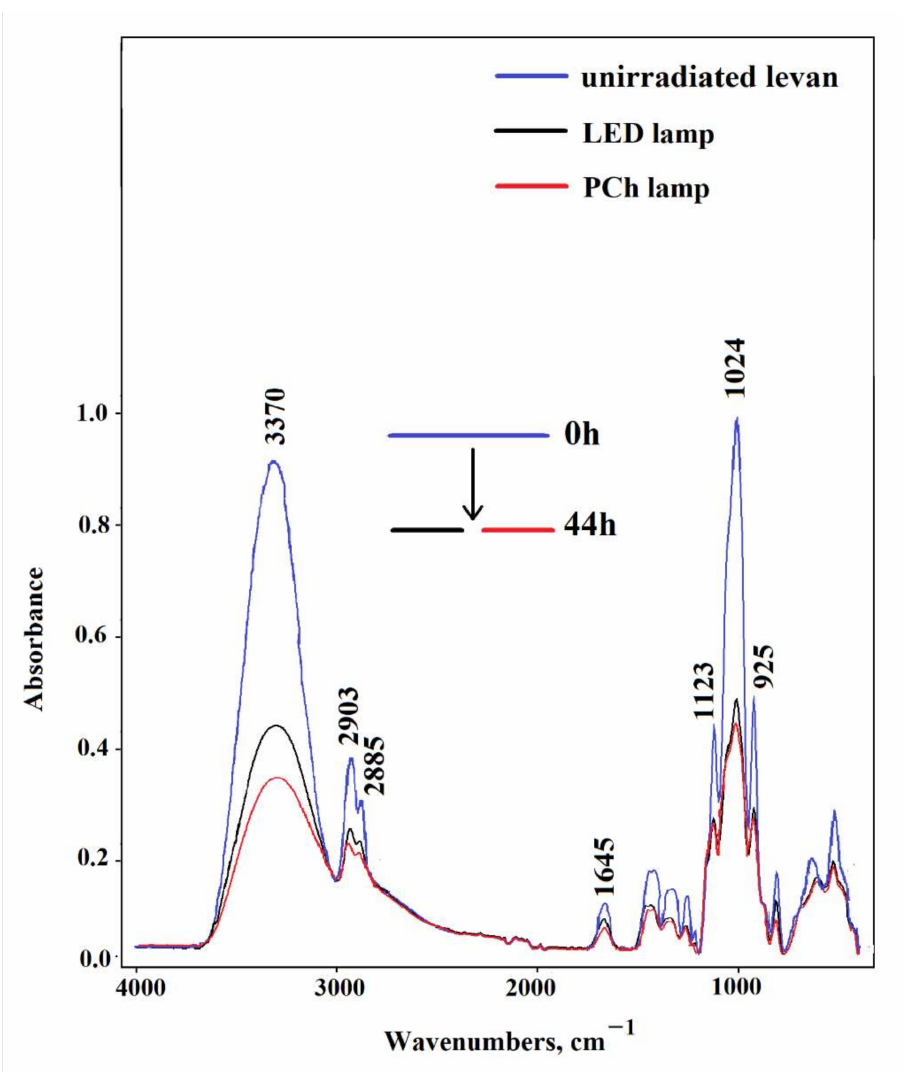
Figure 2. FTIR spectrum for levan films before and after UV irradiation with polychromatic and LED